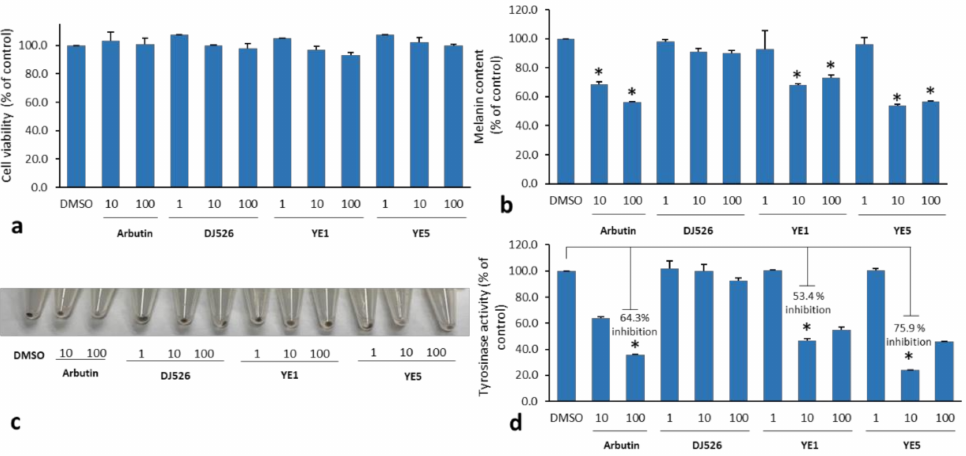
Figure 2. Anti-melanogenesis effects of yeast extract-treated DJ526 seeds extracts. ( a ) Percentage cell viability of melan-a cells after 72 h of exposure to non-elicitor treatment (DJ526) and YE1 and YE5-treated DJ526 seeds extracts compared with the control (DMSO). ( b , c ) YE1 and YE5-treated DJ526 seeds showed significantly reduced melanin content and ( d ) inhibited cellular tyrosinase activity in melan-a cells compared with the vehicle control (DMSO) and DJ526 without elicitation, and the inhibitory activities were similar to the positive control (arbutin). Student’s t -test was used for statistical analyses. * p < 0.05 indicates statistically significant differences compared with the control